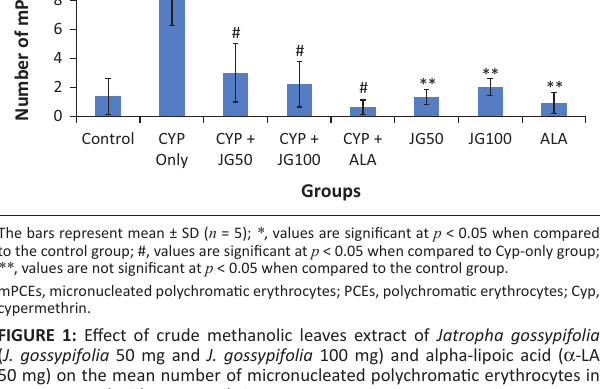
FIGURE 2: Effect of crude methanolic leaves extract of Jatropha gossypifolia ( J. gossypifolia 50 mg and J. gossypifolia 100 mg) and alpha-lipoic acid on the p53 concentration of plasma and liver in rats pretreated with